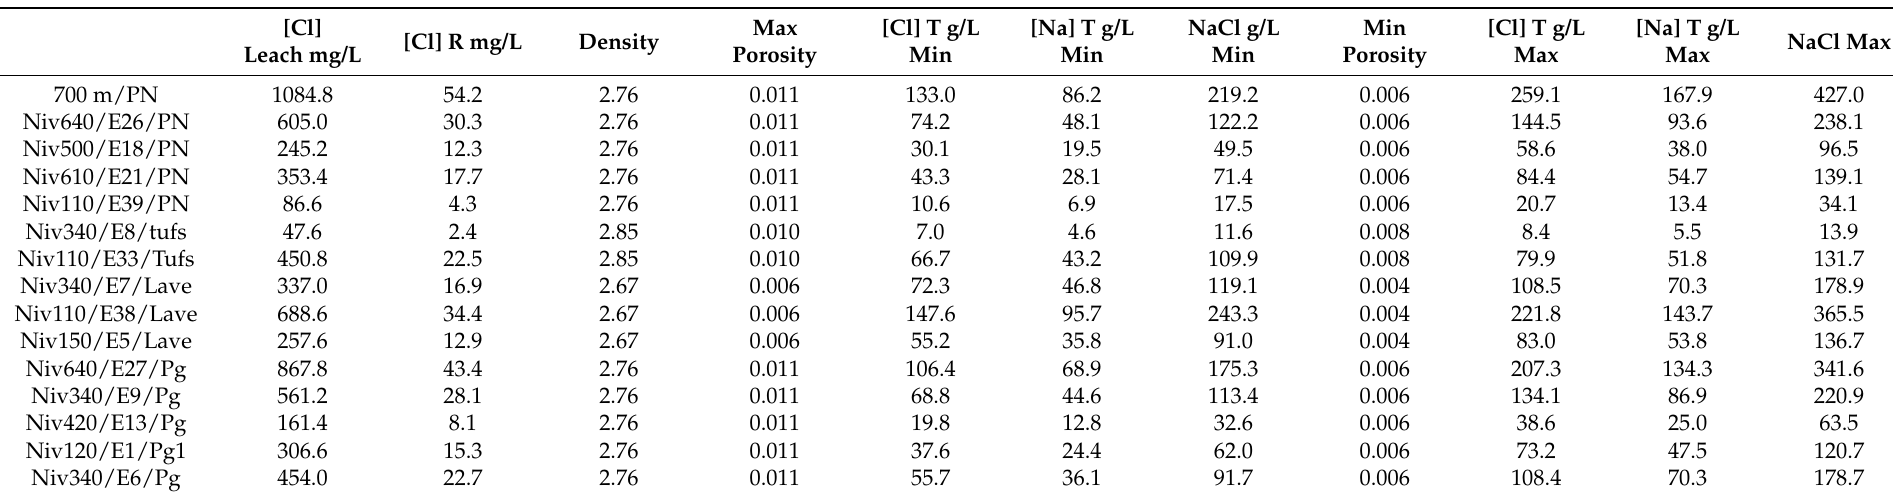
Table 4. Leaching Cl − concentrations and maximum and minimum concentrations calculated from the